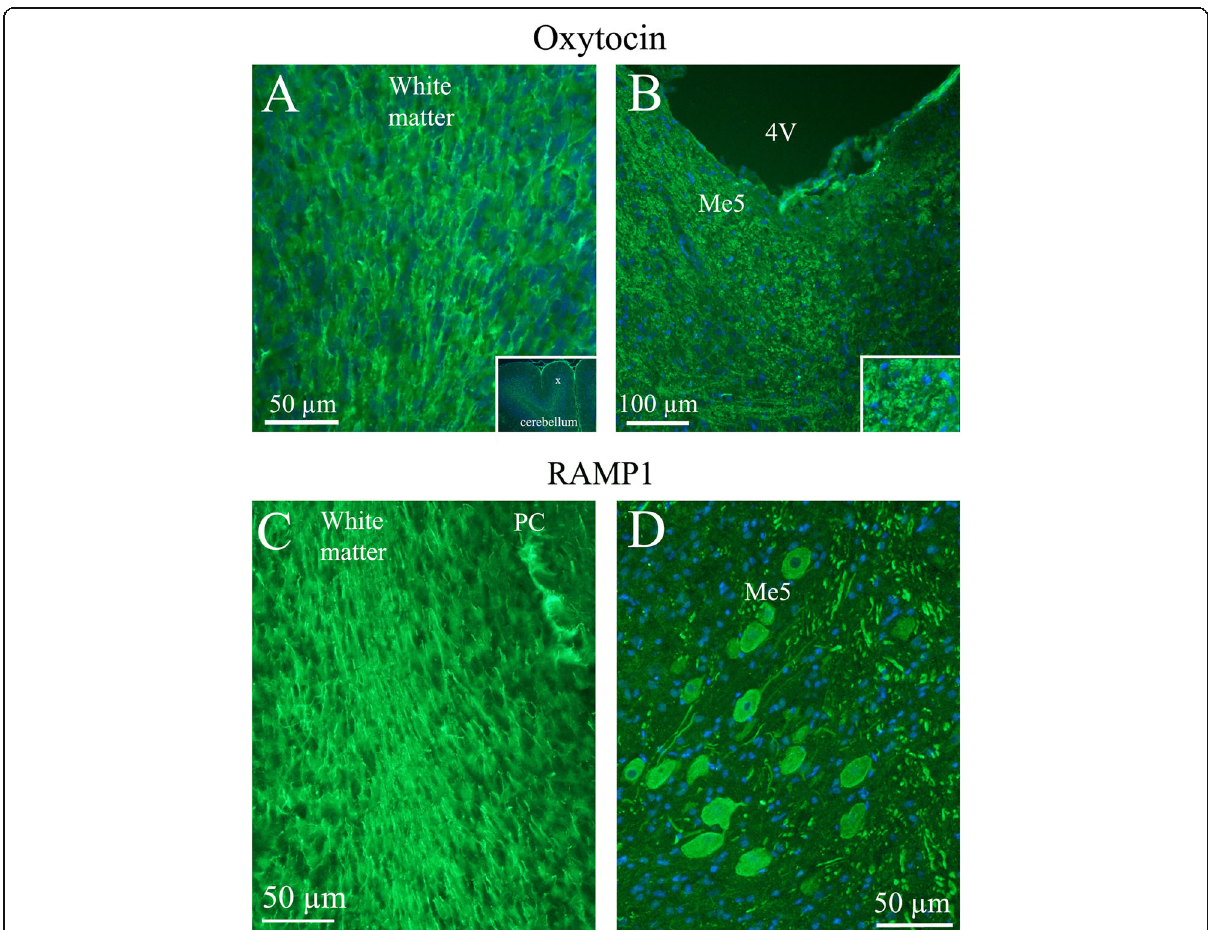
Fig. 5 Oxytocin immunohistochemistry in the cerebellum and the Mesencephalic trigeminal nucleus. a . Oxytocin immunoreactivity was found in fibers in the cerebellar white matter and to some extend in the granular cell layer. No oxytocin positivity was observed in the Purkinje cell layer (PC) or the molecular layer. Insert: a low magnification image of cerebellar lobes. X indicates where the large magnification image is selected. b . In the Mesencephalic trigeminal nucleus (Me5), intense oxytocin immunoreactivity was found. In addition, surrounding the Me5 positive slender fibers were demonstrated. Insert: Higher magnification of Me5. c . The lower row shows in comparison RAMP1 immunoreactivity [25]. The staining of the white matter agrees with the one seen in the oxytocin staining. However, RAMP1 is also found in PC, which is not the case with oxytocin. d . RAMP1 staining showed distinct neuronal cytoplasmatic staining and, in addition, thick fiber